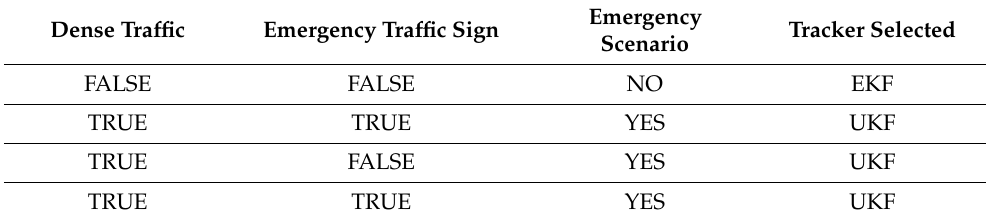
Table 6. Tracker selection based on the output of TSR and RTDE.